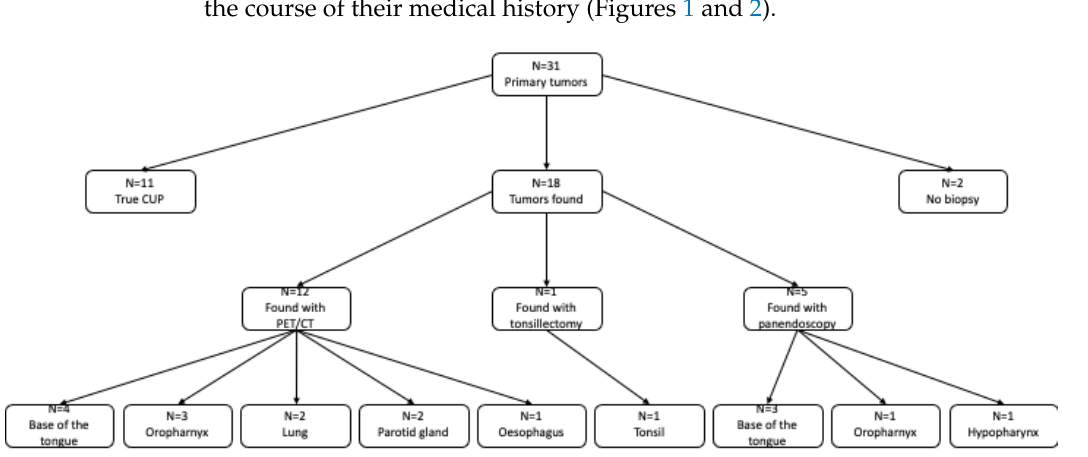
Figure 1. Patient collective.